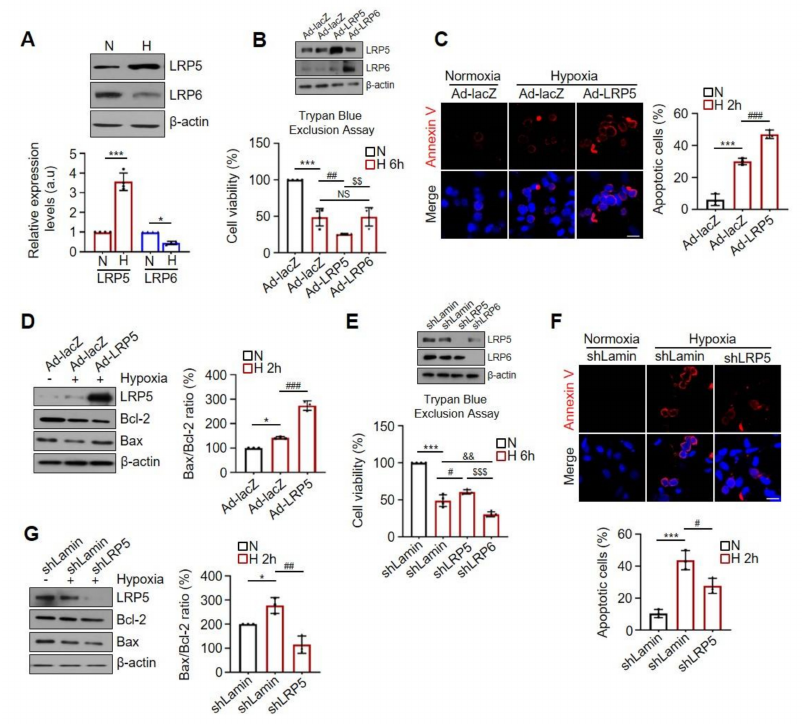
Figure 1. Distinct role of LRP5 and LRP6 in hypoxia-induced cardiomyocyte death. ( A ) Representative western blots showing LRP5 and LRP6 expression in cardiomyocytes exposed to hypoxic conditions (O 2 1.2%) for 6 h. Protein levels were normalized to β -actin levels. n = 4/group. Means ± SD. * p < 0.05, *** p < 0.001 versus each control. ( B ) Relative percent cell viability was assessed using trypan blue exclusion assay in Ad-lacZ-, Ad-LRP5-, and Ad-LRP6-infected hypoxic cardiomyocytes. Normoxia (O 2 21%) is indicated as “N”, and hypoxia is indicated as “H”. Cell viability was normalized to the normoxic Ad-lacZ control. n = 4/group. Means ± SD. *** p < 0.001 versus Normoxia; ## p < 0.01 Ad-LRP5 versus Ad-lacZ; $$ p < 0.01 Ad-LRP6 versus Ad-LRP5; NS, no significance. ( C ) Representative fluorescence image of Annexin V-Cy3.18 staining (red) for Ad-lacZ- and Ad-LRP5-infected hypoxic cardiomyocytes. Nuclei were stained with DAPI (blue). Scale bar, 200 µ m. Apoptosis rate was quantified with SIBIA software. n = 3/group. Means ± SD. *** p < 0.001 versus Normoxia; ### p < 0.001 Ad-LRP5 versus Ad-lacZ. ( D ) Representative western blots showing Bcl-2 and Bax expression for Ad-lacZ- and Ad-LRP5- infected hypoxic cardiomyocytes. Results are presented as a ratio and converted into %. n = 3/group. Means ± SD. * p < 0.05 versus Normoxia; ### p < 0.001 Ad-LRP5 versus Ad-lacZ. ( E ) Relative percent cell viability assessed using trypan blue exclusion assay in AdLamin-, shLRP5-, and shLRP6-infected hypoxic cardiomyocytes. Cell viability was normalized to the normoxic Ad-lacZ control. G; n = 4; H; n = 3. Means ± SD. *** p < 0.001 versus Normoxia; # p < 0.05 shLRP5 versus shLamin; $$$ p < 0.001 shLRP6 versus shLRP5; && p < 0.01 shLRP6 versus shLamin. ( F ) Representative fluorescence image of Annexin V-Cy3.18 staining (red) for AdLamin and shLRP5-infected hypoxic cardiomyocytes. Nuclei were stained with DAPI (blue). Scale bar, 200 µ m. n = 3/group. Means ± SD. *** p < 0.001 versus Normoxia; # p < 0.05 shLRP5 versus shLamin. ( G ) Representative western blots showing Bcl-2 and Bax expression for AdLamin- and shLRP5-infected hypoxic cardiomyocytes. Results are presented as a ratio and were converted into %. n = 3/group. Means ± SD. * p < 0.05 versus Normoxia; ## p < 0.01 shLRP5 versus